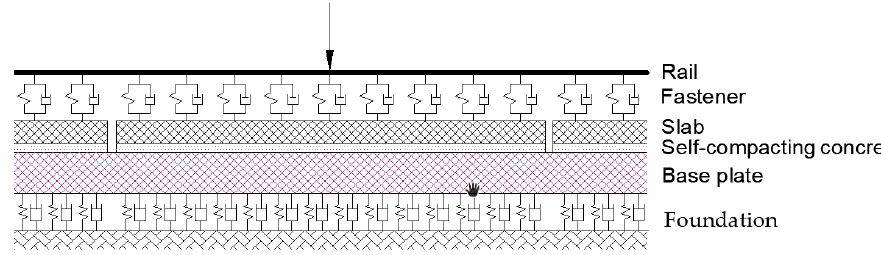
Figure 13. Loading method.